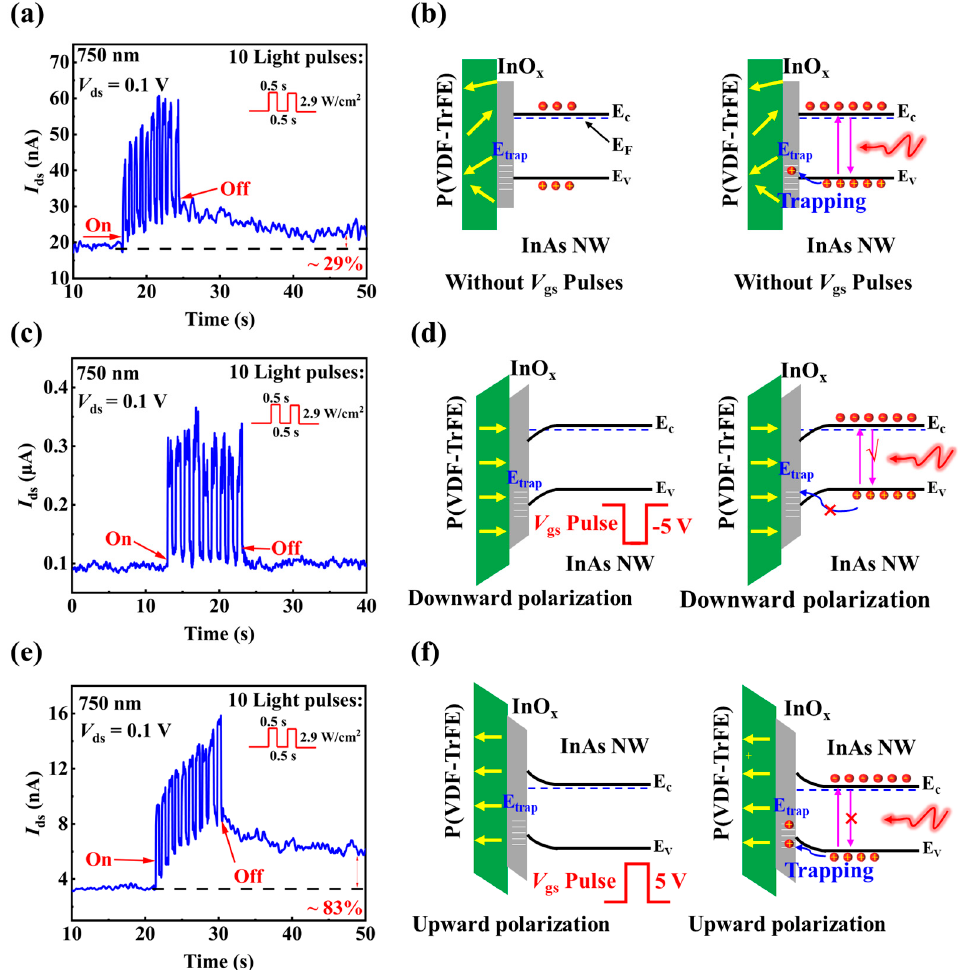
Figure 10. ( a ) The EPSCs response to the stimulation of 10 consecutive light pulses for the P(VDF-TrFE)-coated InAs NW FET before applying V gs pulses. ( b ) The energy band diagrams of the P(VDF-TrFE)-coated InAs NW FET before applying V gs pulses. ( c ) The EPSCs response to the stimulation of 10 consecutive light pulses for the P(VDF-TrFE)-coated InAs NW FET after applying negative V gs pulses. ( d ) The energy band diagrams of the P(VDF-TrFE)-coated InAs NW FET after applying negative V gs pulses. ( e ) The EPSCs response to the stimulation of 10 consecutive light pulses for the P(VDF-TrFE)-coated InAs NW FET after applying positive V gs pulses. ( f ) The energy band diagrams of the P(VDF-TrFE)-coated InAs NW FET after applying positive V gs pulses. In ( b , d , f ), the left and right images are the diagrams before and after light illumination, respectively. The yellow arrows in ( b , d , f ) represent the residual polarization direction in P(VDF-TrFE).